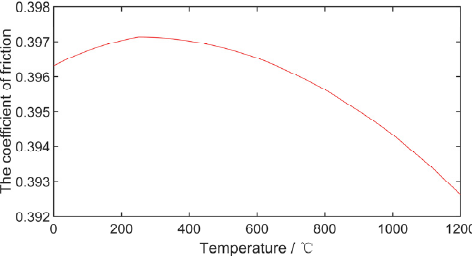
Figure 3. Variation curve of the friction coefficient of the C/C brake disc with temperature.